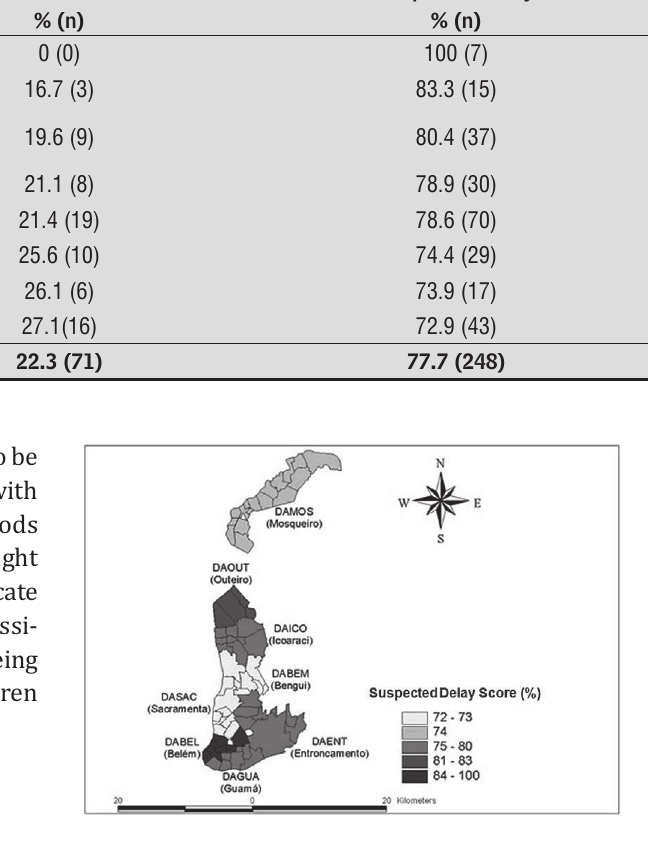
Figure 2 - Map of the Percentages of suspected NPMD delay, According to the Denver II in the Administrative Districts of Belém –